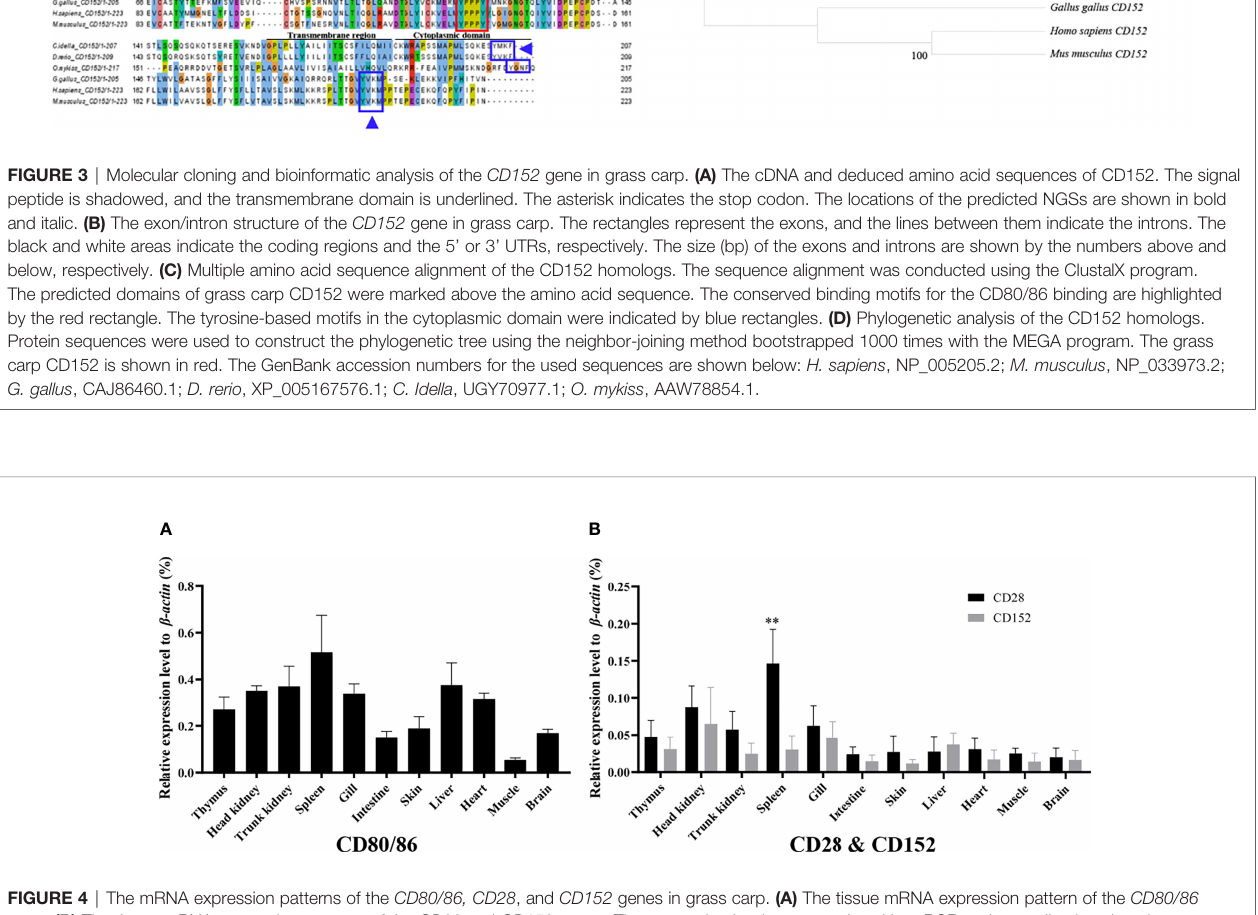
FIGURE 4 | The mRNA expression patterns of the CD80/86, CD28 , and CD152 genes in grass carp. (A) The tissue mRNA expression pattern of the CD80/86 gene. (B) The tissue mRNA expression patterns of the CD28 and CD152 genes. The expression levels were analyzed by qPCR and normalized against the expression of b -actin using the 2 − D Ct method. The p -value was calculated using ANOVA with the LSD post hoc test (** p < 0.01). Data are represented as the mean ± SEM for fi ve individual fi